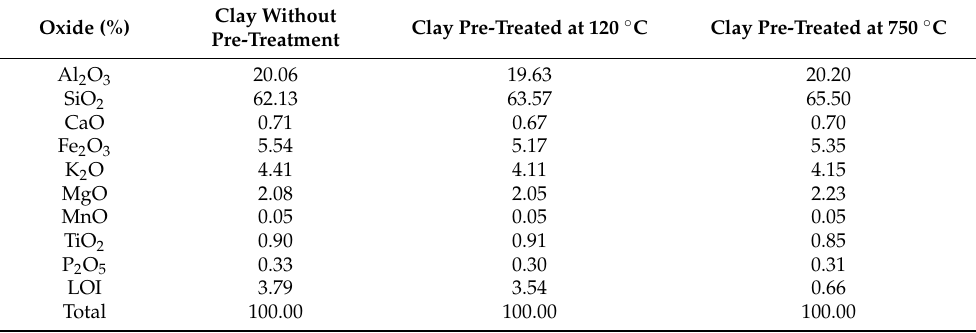
Table 1. Oxide composition of